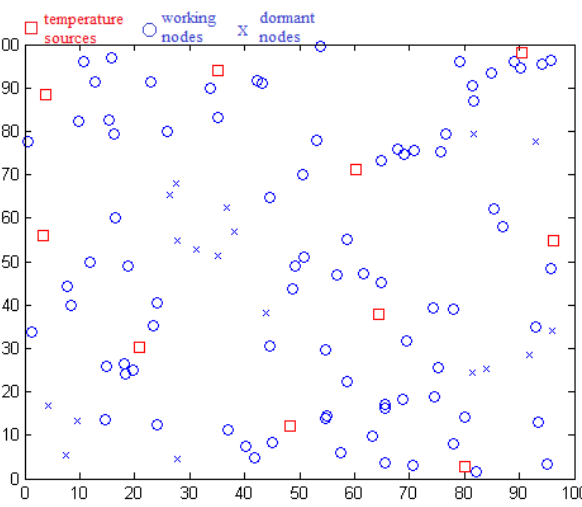
Figure 3. Topology